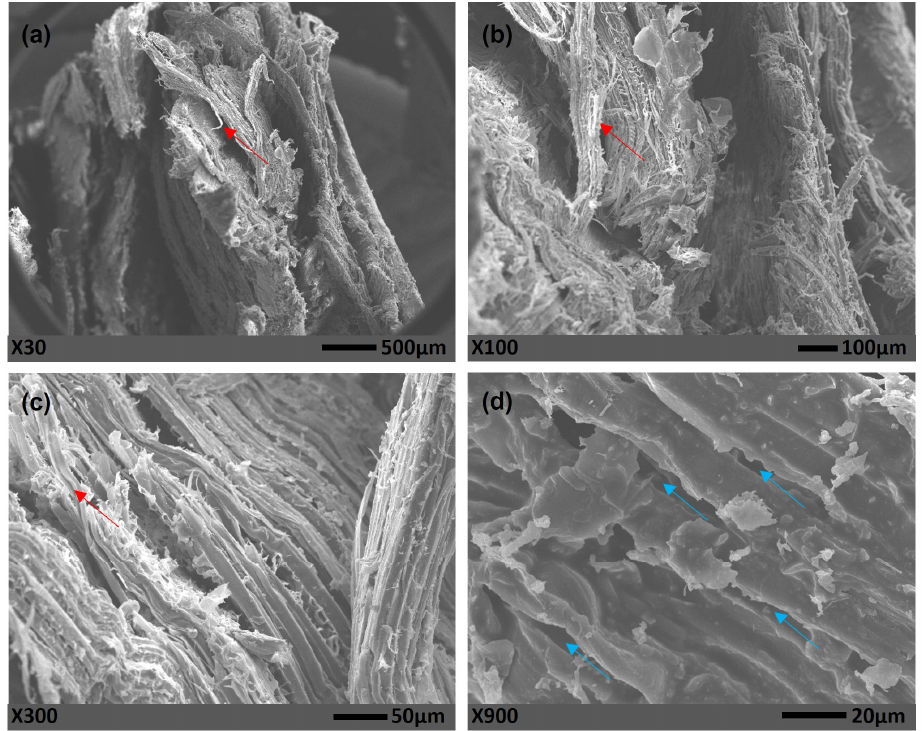
Figure 7. SEM of composites manufactured by hot pressing, without chamotte, ( a – c ) showing with different magnifications the fibers pulled out and ( d ) with high magnification the voids around the fibers. Through Figure 7, it was not possible to notice the presence of bubbles in the polyurethane matrix, in addition to the fibers defibrillations and pulled out of matrix (red arrows), voids (blue arrows) around the eucalyptus fibers. No bubbles were observed in the matrix, which could be due to its low volume fraction in the composite panel. It was observed in Figure 7a–c that there is a small amount of polyurethane resin, making it difficult to show it. This corroborates the low physical properties results obtained by hot-manufactured panels when compared to cold-manufactured ones [12]. Figure 8 presents the SEM images for the composite panels manufactured by hot pressing, with the addition of chamotte in its formulation.